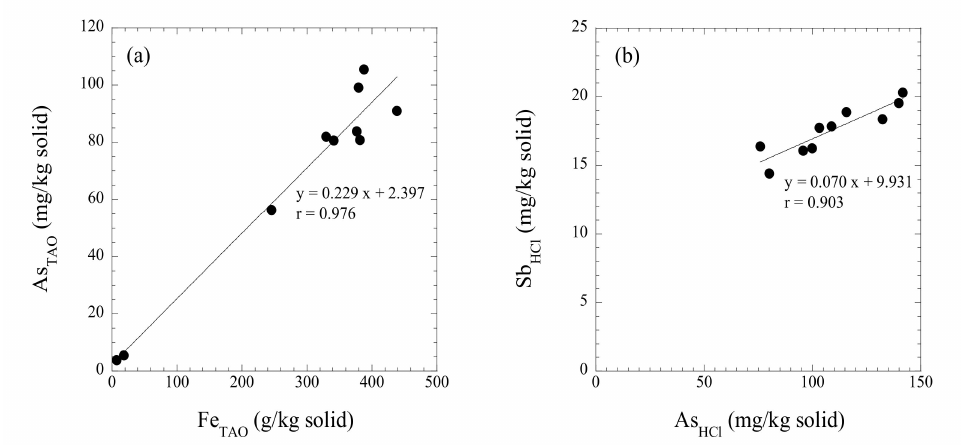
Figure 8. Relationship between elements extracted with each reagent. ( a ) Relationship between As and Fe contents of amorphous material as TAO soluble phase. ( b ) Relationship between As and Sb contents in 6 M HCl soluble phase. The axis label is named as follows: Fe TAO and As TAO represent the Fe and As content extracted by TAO reagent, respectively, and Sb HCl and As HCl , represent the Sb and As extracted by 6 M HCl reagent,